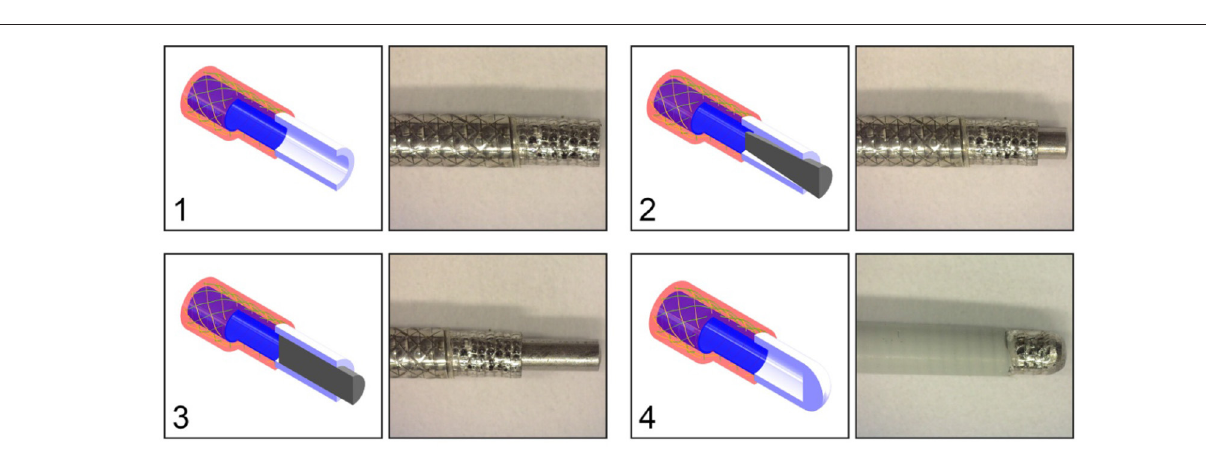
FIGURE 11 | Catheter tip designs. Top left: (1) open tip . Top right: (2) closed tip with conical pin . Bottom left: (3) closed tip with cylindrical pin . Bottom right: (4) closed compliant tip . All the tips are connected to the closed coil catheter shaft without PTFE liner. Color indications: blue = flat wire coil, green and yellow = double internal braiding, red = nylon outer coating, white = tip, and gray = cylindrical or conical pin.